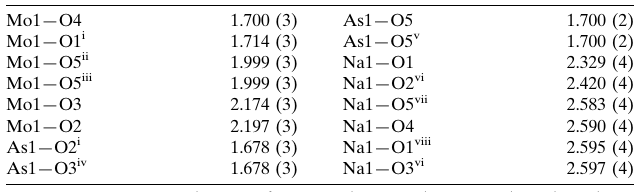
Tableau 1 Parame`tres ge´ome´triques(A˚